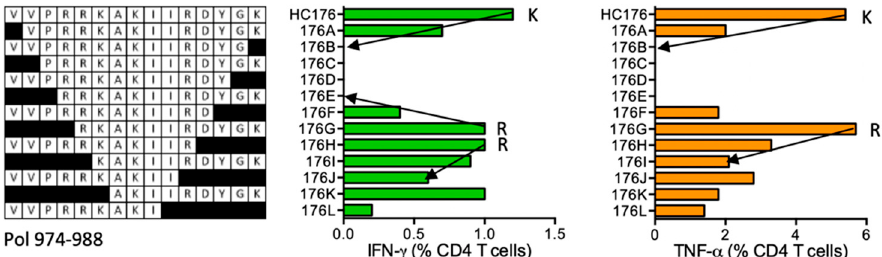
Figure 17. HC176/VID 413—definition of CD4 + T-cell epitopes in HIV-1 protein Pol. HC176-cultured